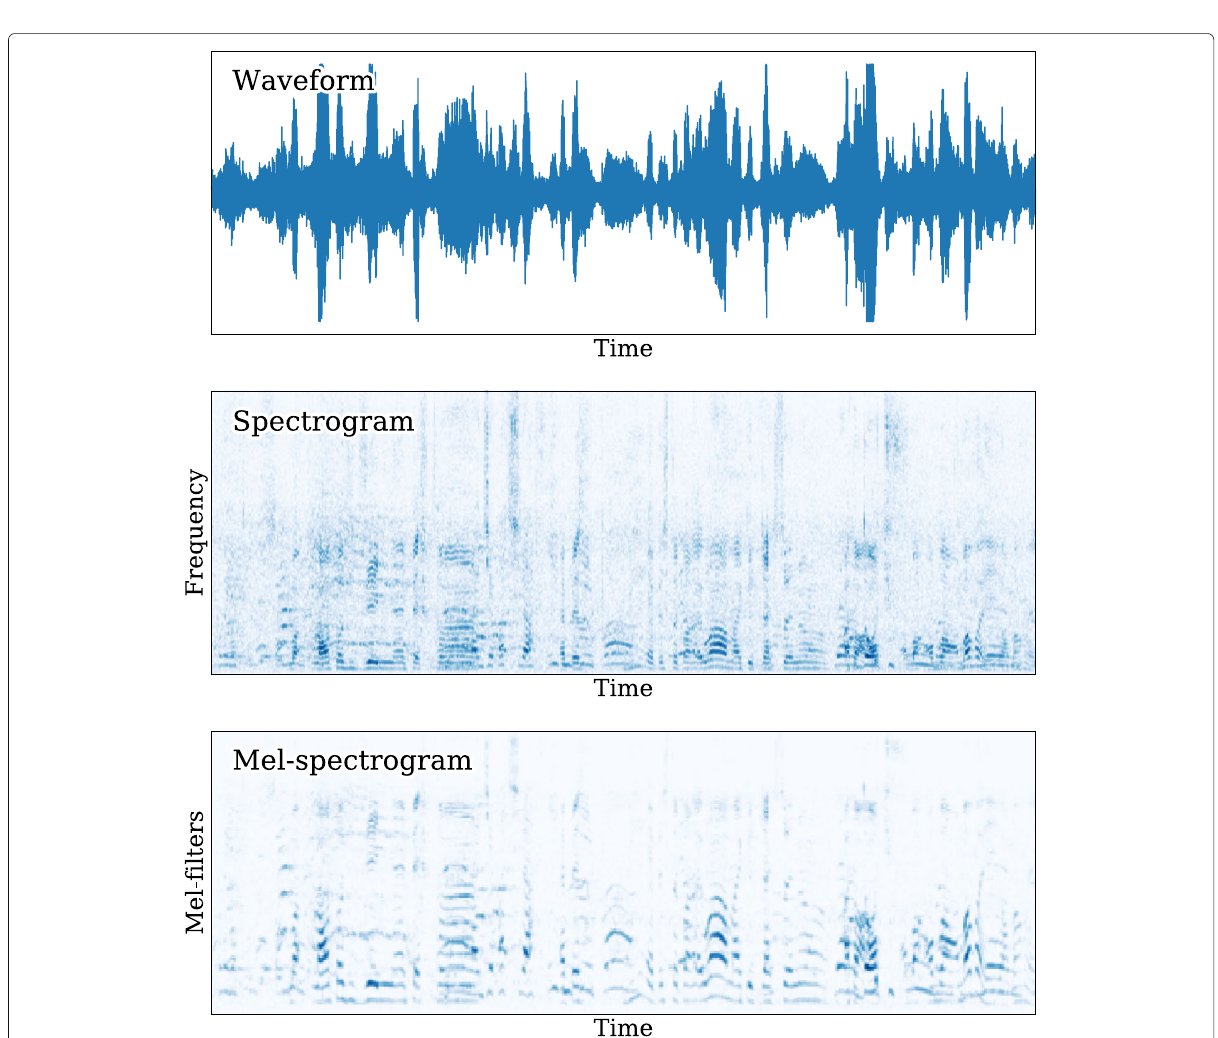
Fig. 1 Waveform, spectrogram, and mel-spectrogram of a 10-s speech segment obtained from Google AudioSet. The mel-spectrogram, based on the auditory-based mel-frequency scale, provides better resolution for lower frequencies than the spectrogram